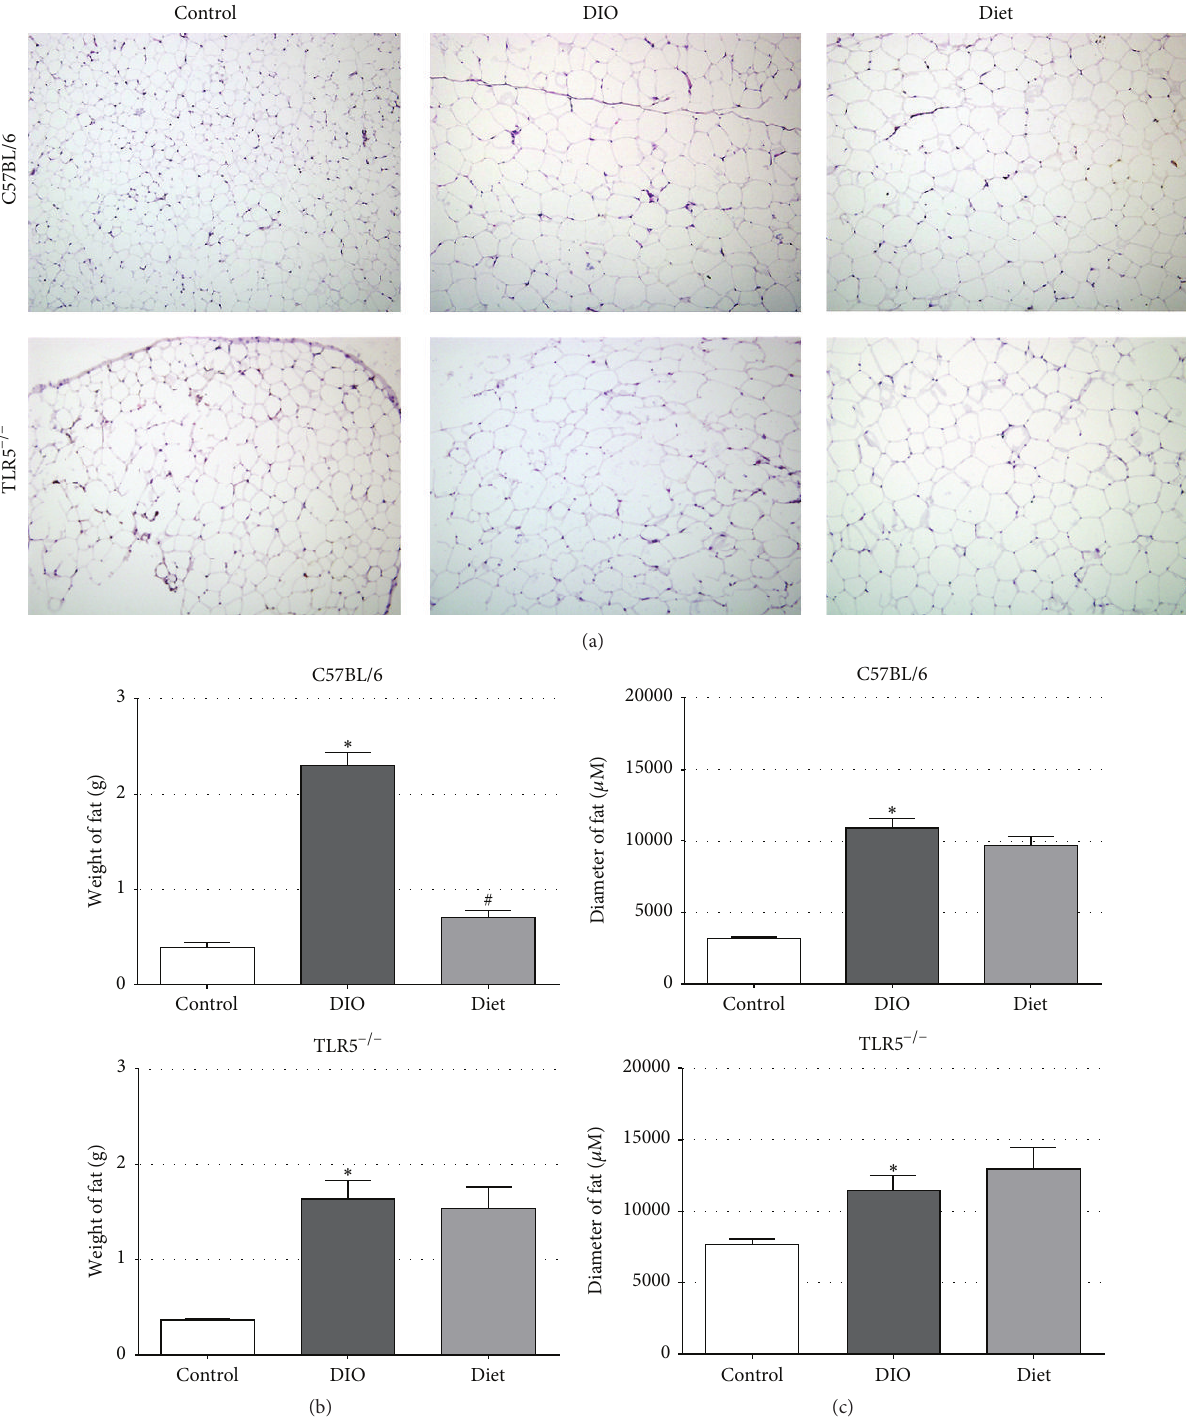
Figure 3: (a) Hematoxylin and eosin stain of the paraffin-embedded epididymal white adipose tissue at 5 𝜇 m section of C57BL/6 and TLR5 −/−